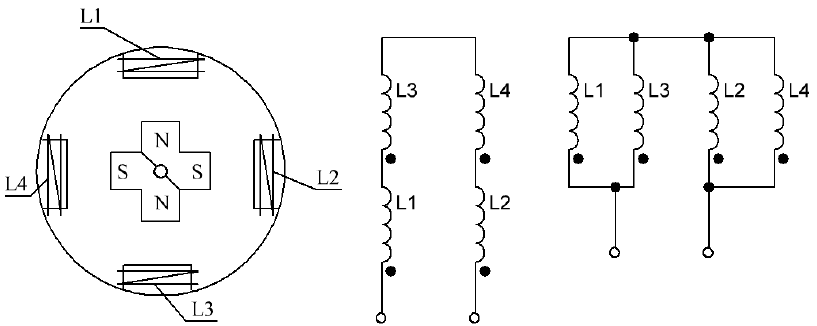
Figure 2. Higher-capacity generator.